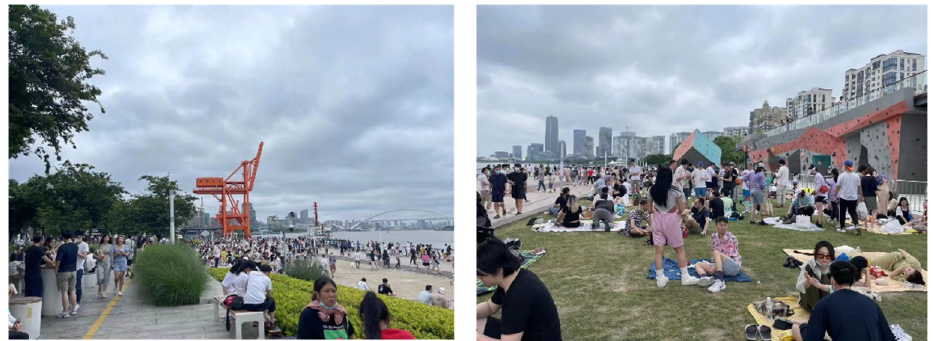
Figure 2. The photos of the evacuation points in Binjiang Green Space, Xuhui District, Shanghai, China on 5 May 2021.